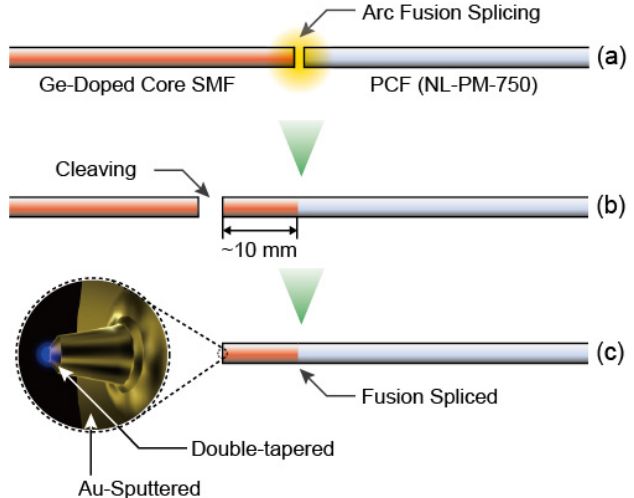
Figure 4. Fabrication of fusion-spliced near-field optical fiber for high-sensitivity near-field fluorescence detection. (a) The SMF and the PCF are fusion-spliced, (b) The spliced fiber is cleaved at the SMF side with the remaining length of the SMF up to 10 mm, in order to decrease the auto-fluorescence generated from the dopant of the SMF, (c) The double-tapered probe tip is then fabricated at the end face of the SMF